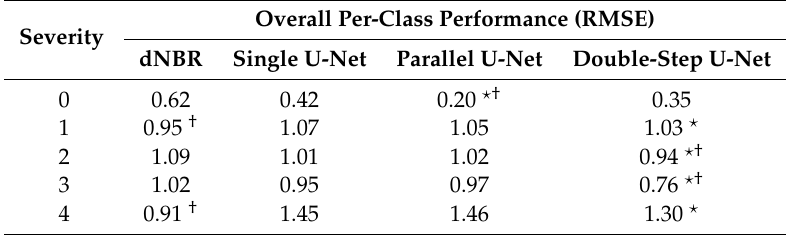
Table 6. Average performance for severity level. ( (cid:63) ) indicates the best RMSE per severity category among the three U-Net versions. ( † ) indicates the best RMSE per severity category, dNBR